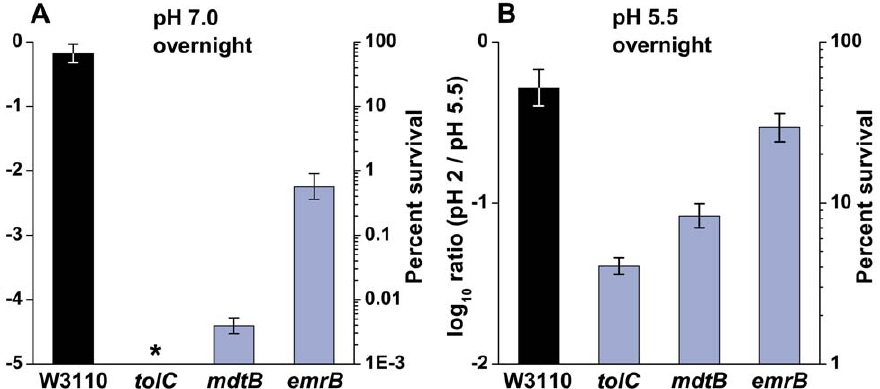
Figure 1. TolC, EmrB, and MdtB are required for extreme-acid survival. Strains W3110 (K-12 parent strain), JLS1015 (W3110 tolC :: kan ), JLS1027 (W3110 emrB :: kan ), and JLS1024 ( mdtB :: kan ) were diluted into LBK pH 2 and exposed with rotation for 2 hours at 37 u C after overnight growth to stationary phase in buffered LBK at A ) pH 7.0 for non-acid-adapted cells and B ) pH 5.5 for acid-adapted cells. Error bars=SEM, n=6. *Below the level of